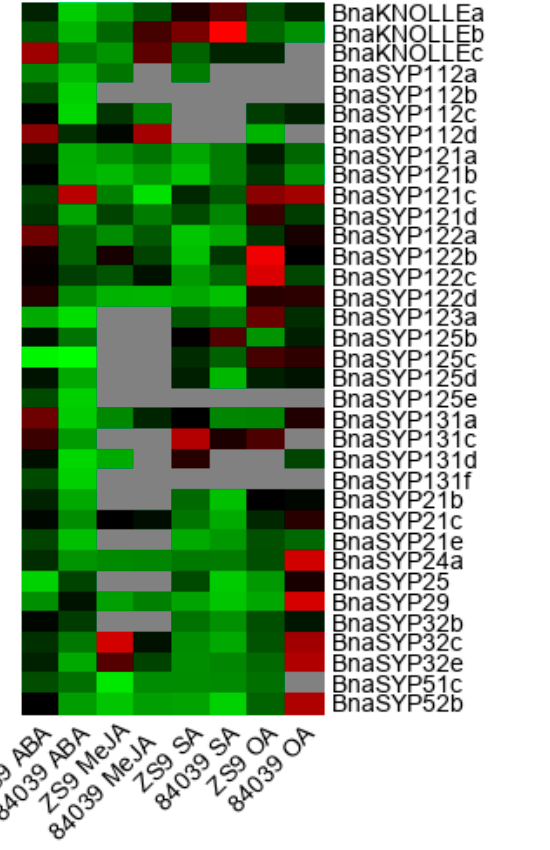
Figure 7. Expression profiles of Qa- BnaSNAREs in resistant variety Zhongshuang9 and susceptible variety 84039 of B. napus under treatment with ABA, MeJA, SA, and OA. Green and red colors are used to represent low-to-high expression levels, and colors scales correspond to the fold-change values compared with the counterpart control. RT-qPCR data were calculated by the method of 2 − ∆∆ CT and appeared after Log2 conversion. The gray color represents no available data. All values were detailed in Table S11.